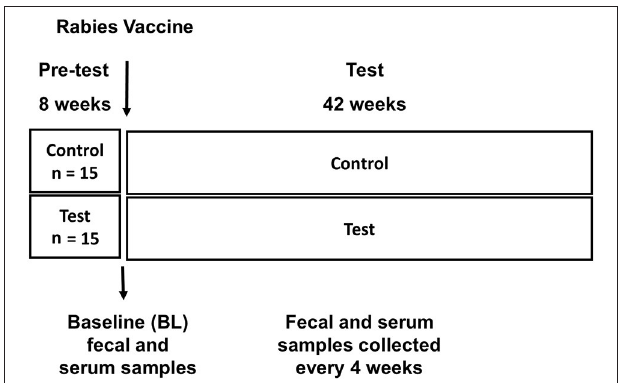
FIGURE 1 | Experimental design: Pre-test phase and Test phase are depicted, along with timing of rabies vaccination, baseline (BL) sample collection, sample collection during test